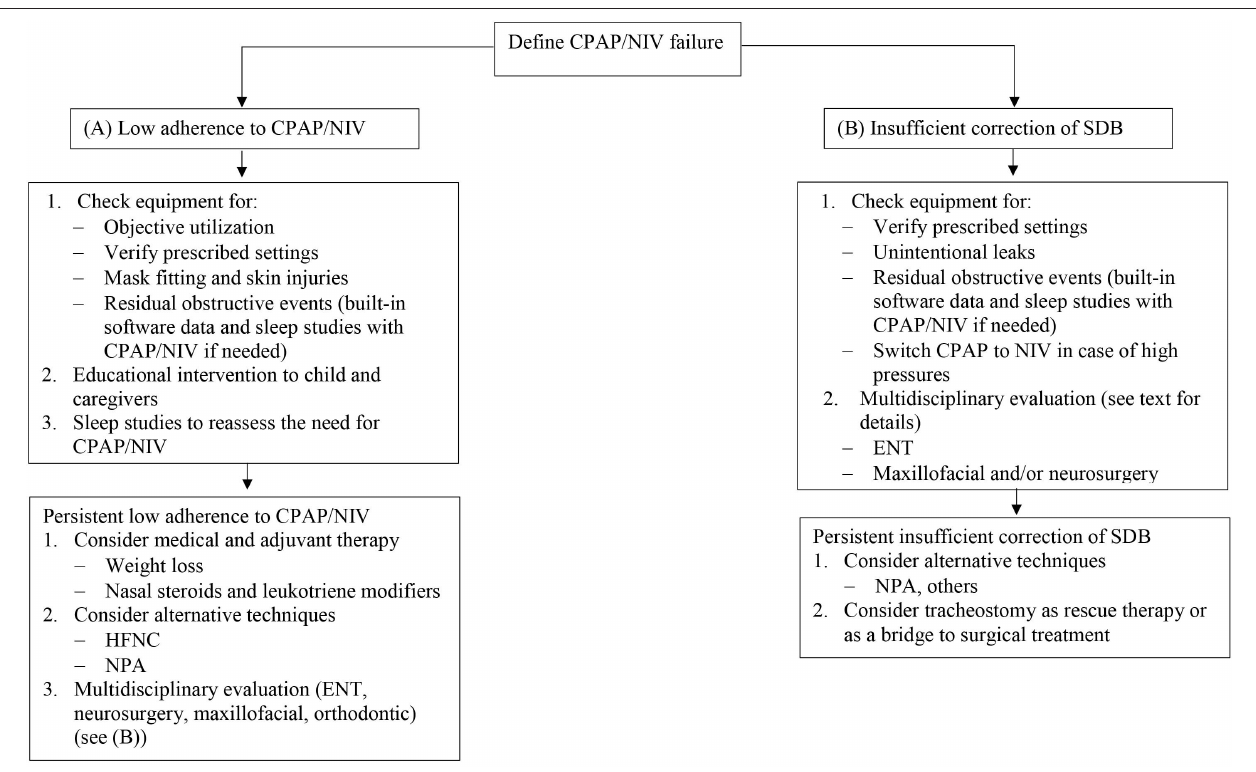
FIGURE 1 | Proposed algorithm for CPAP and NIV failure in OSA. CPAP, continuous positive airway pressure; NIV, non-invasive ventilation; OSA, obstructive sleep apnea; HFNC, high flow nasal cannula; NPA, nasopharyngeal airway; ENT, ear nose and throat; SDB, sleep disordered